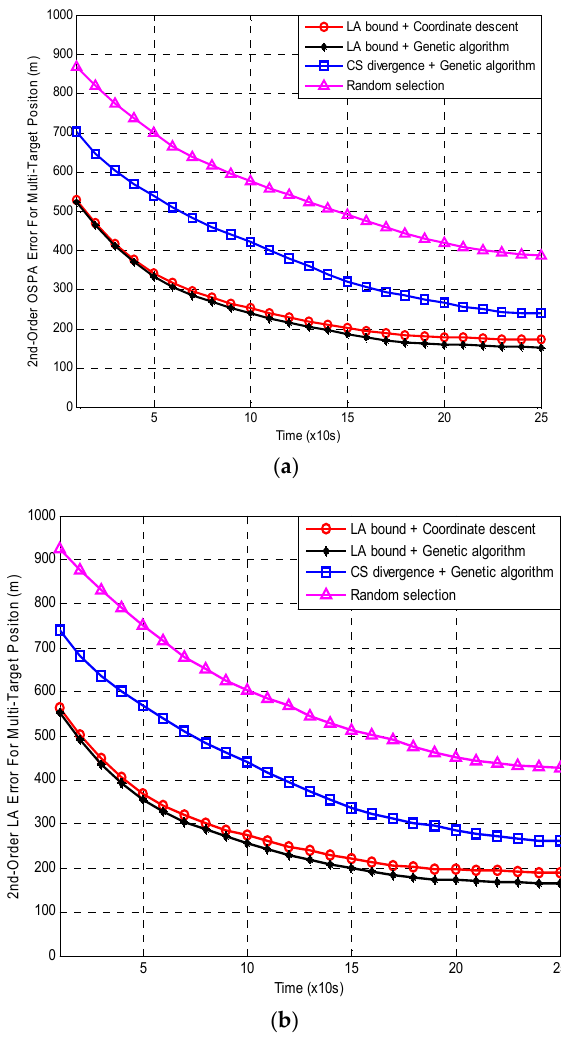
Figure 5. 500 MC averages of ( a ) OSPA and ( b ) LA errors versus time with c = 1000